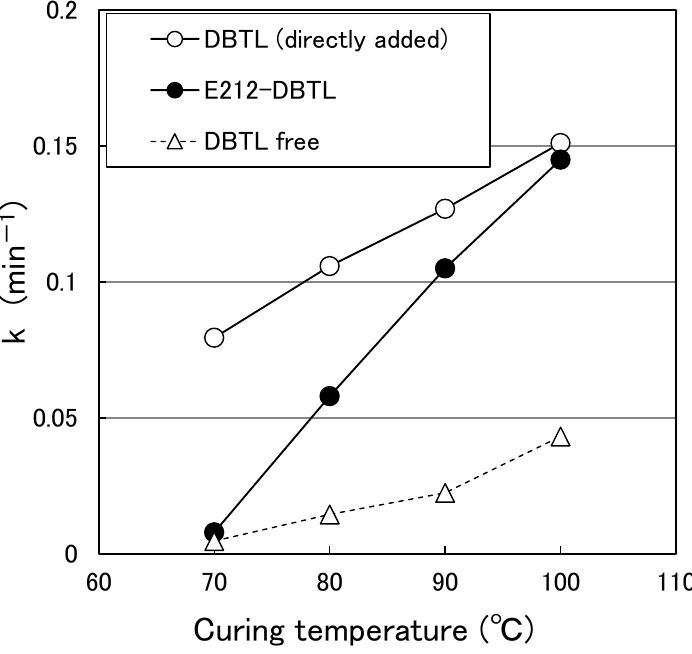
Figure 3. Relationship between the curing speed constant (k) and curing temperature.